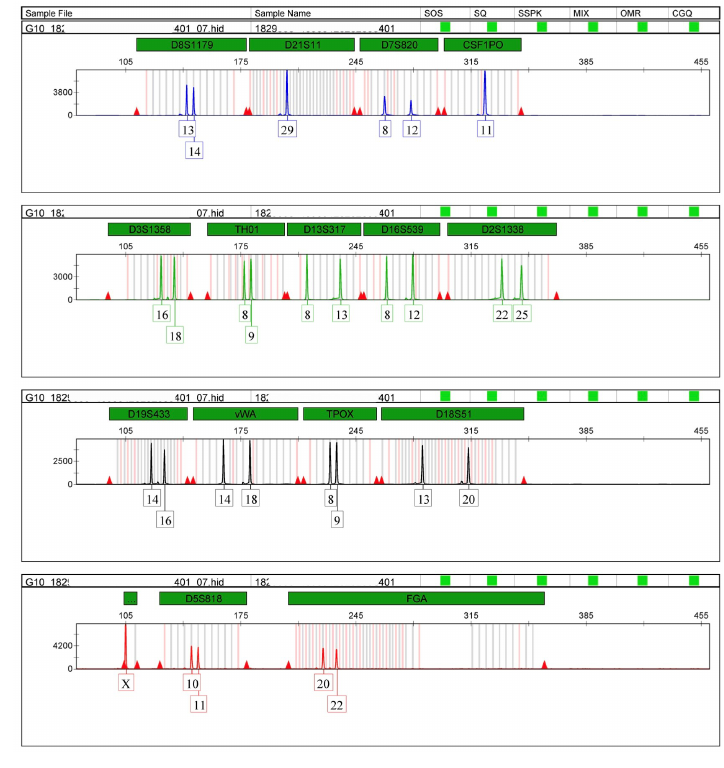
Figure 4. Female DNA profile.